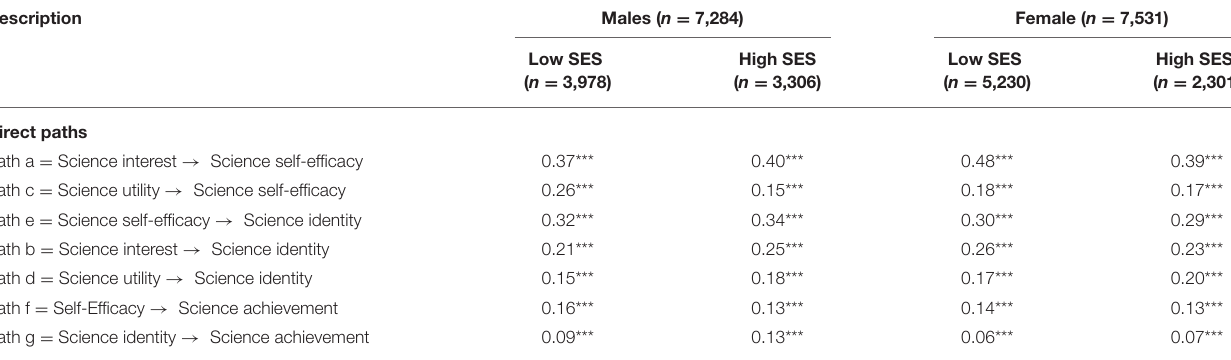
TABLE 4 | PA directs effects estimates for the subgroups derived from the SEM tree.